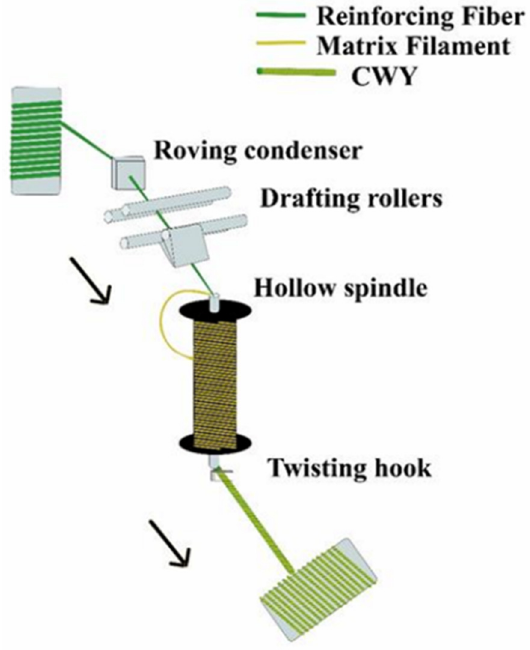
Figure 13. Schematic of co-wrapping process for hybris yarns. Adapted from Reference [56] under Creative Commons license.